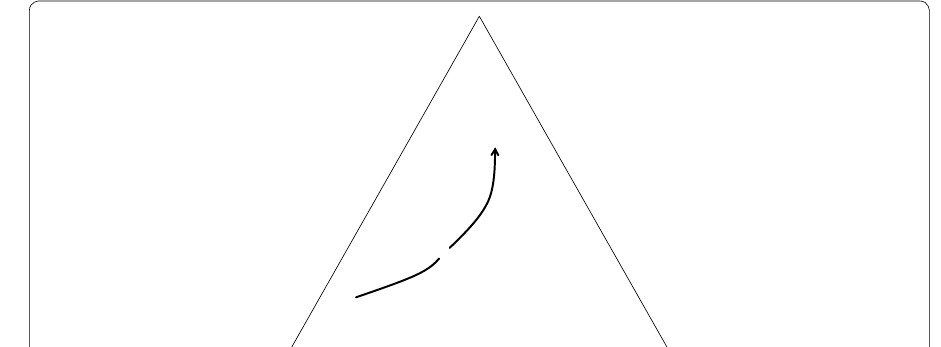
Fig. 4 Example of a non-continuous trajectory on the 2-simplex